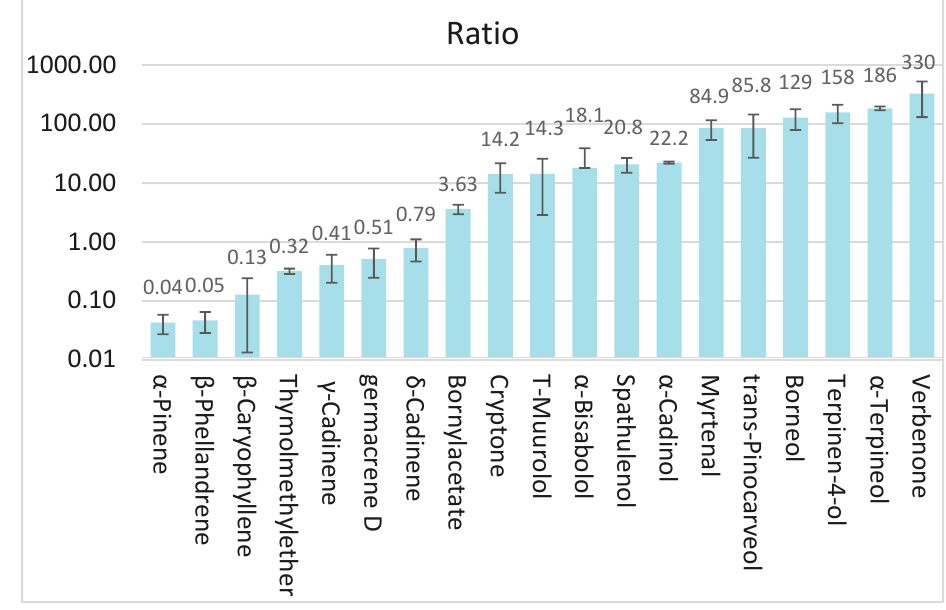
Figure 5. Ratio of volatile percentage in hydrolates to essential oils